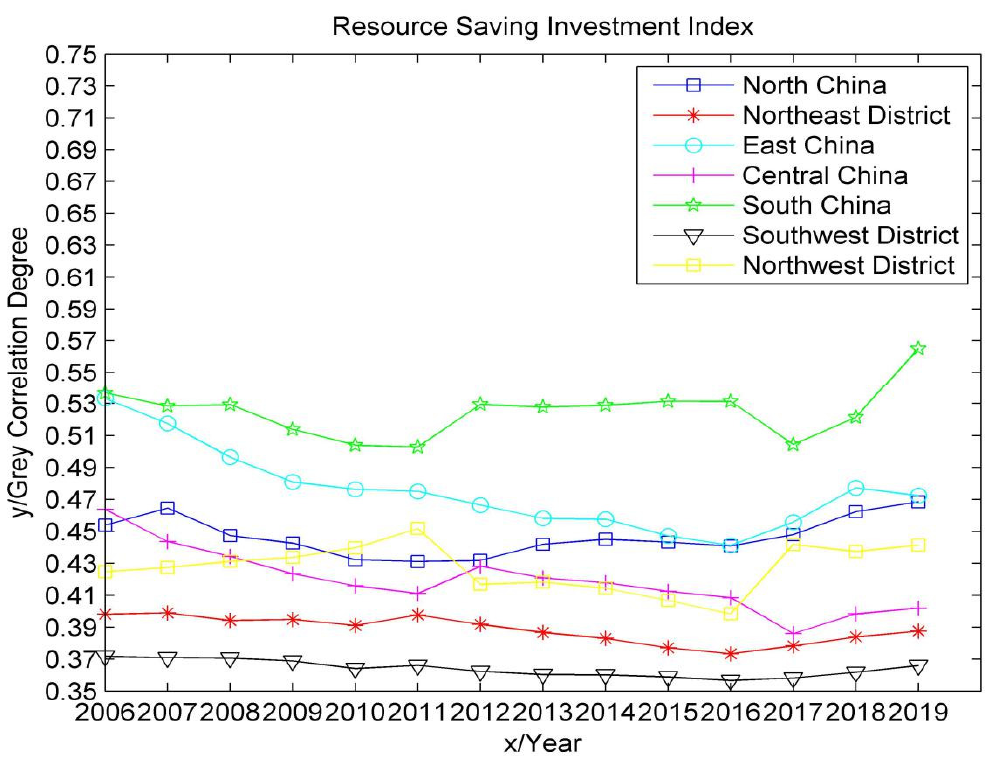
Figure 5. Time series trend of economic and social development indicators of green agriculture.